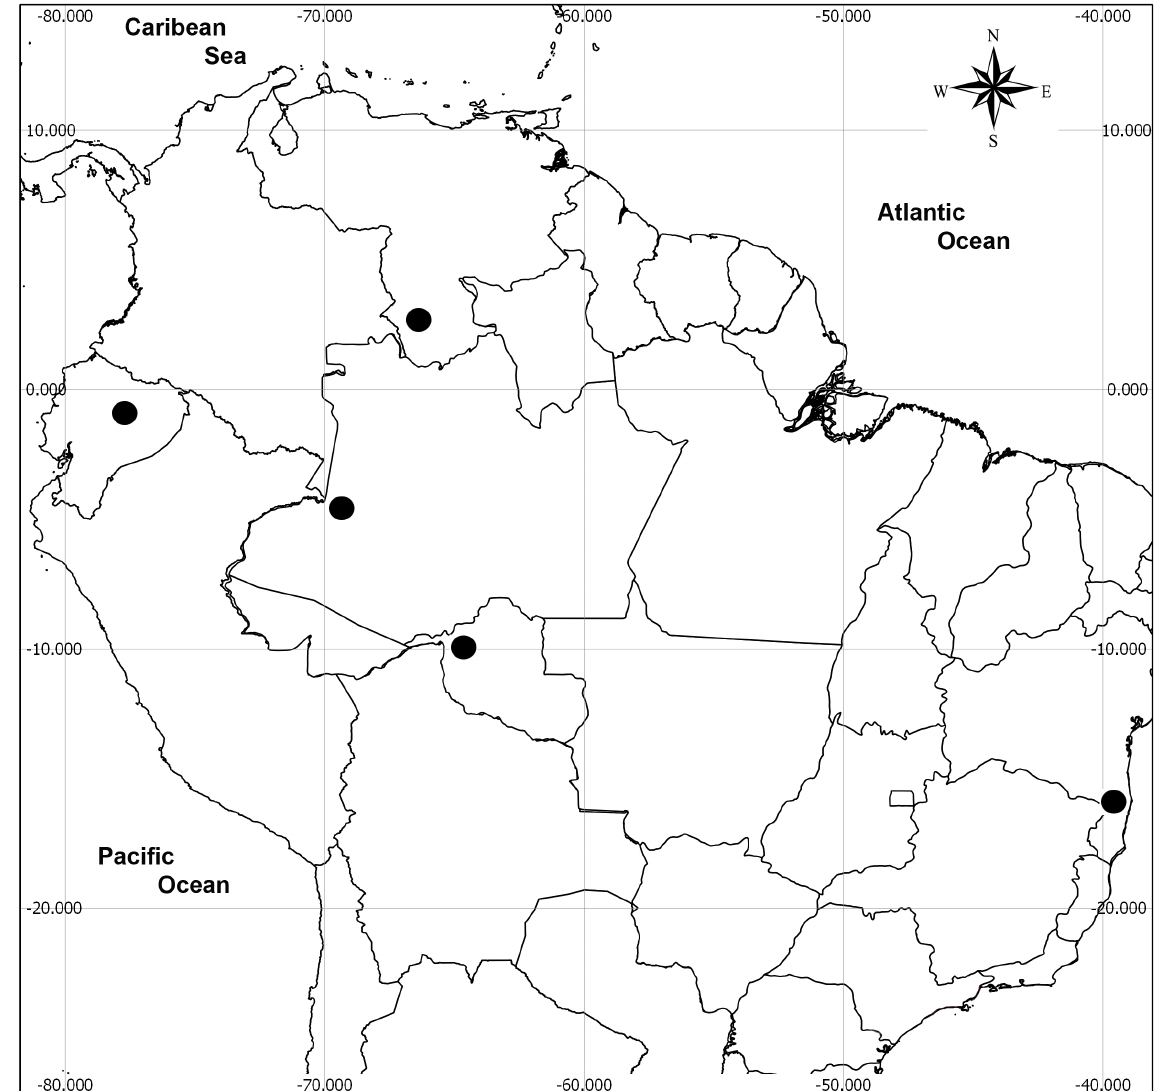
Fig. 5. Distribution map for Kempfidris inusualis (Fernández, 2007) comb.